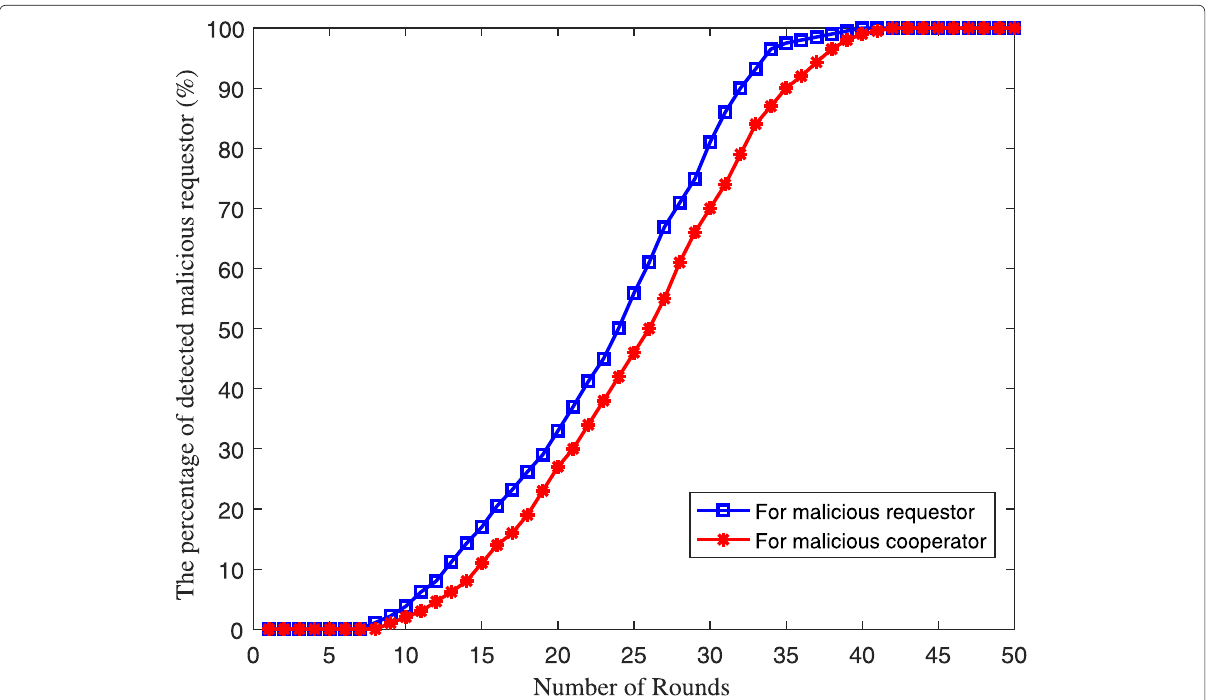
Fig. 10 The percent of case 2 detected malicious